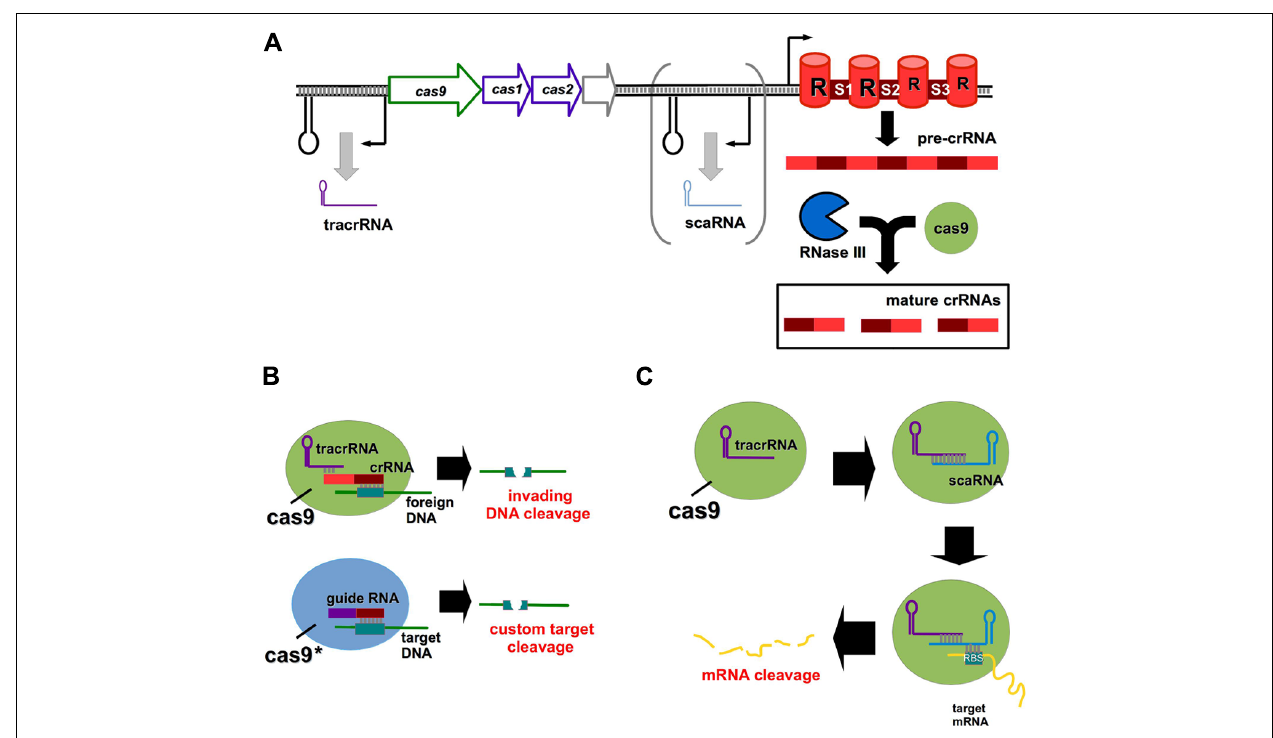
upon association of the mature crRNA with a complementary foreign DNA molecule.The tracrRNA and crRNA components can be replaced by a guide RNA, and the Cas9 enzyme may be mutated to achieve custom DNA target cleavage. (C) The novel scaRNA of certain type II CRISPR systems mediates Cas9 cleavage of a target mRNA transcript by associating with the mRNA at its